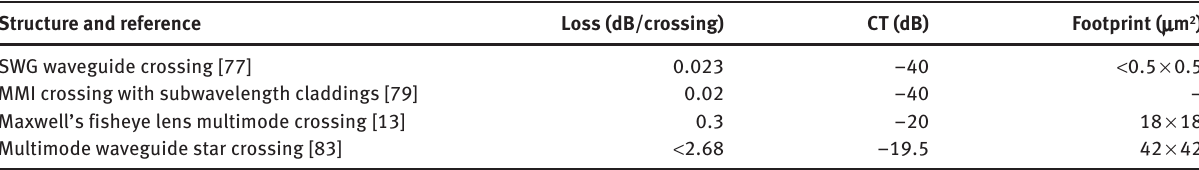
Table 4: Experimental results for subwavelength structured waveguide crossings. Structure and reference